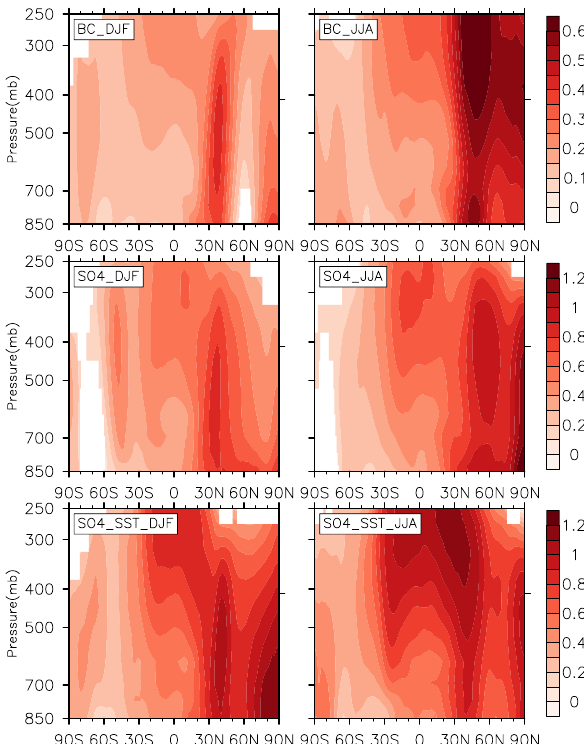
Figure 2. Temperature response ( ◦ C) as a function of latitude and pressure to BC (first row), SO 4 (second row), and SO 4 -induced SST perturbation (SO 4 _SST) (third row). The left and right columns are the DJF and JJA averages, respectively. Note that the color scales for SO 4 and SO 4 _SST are